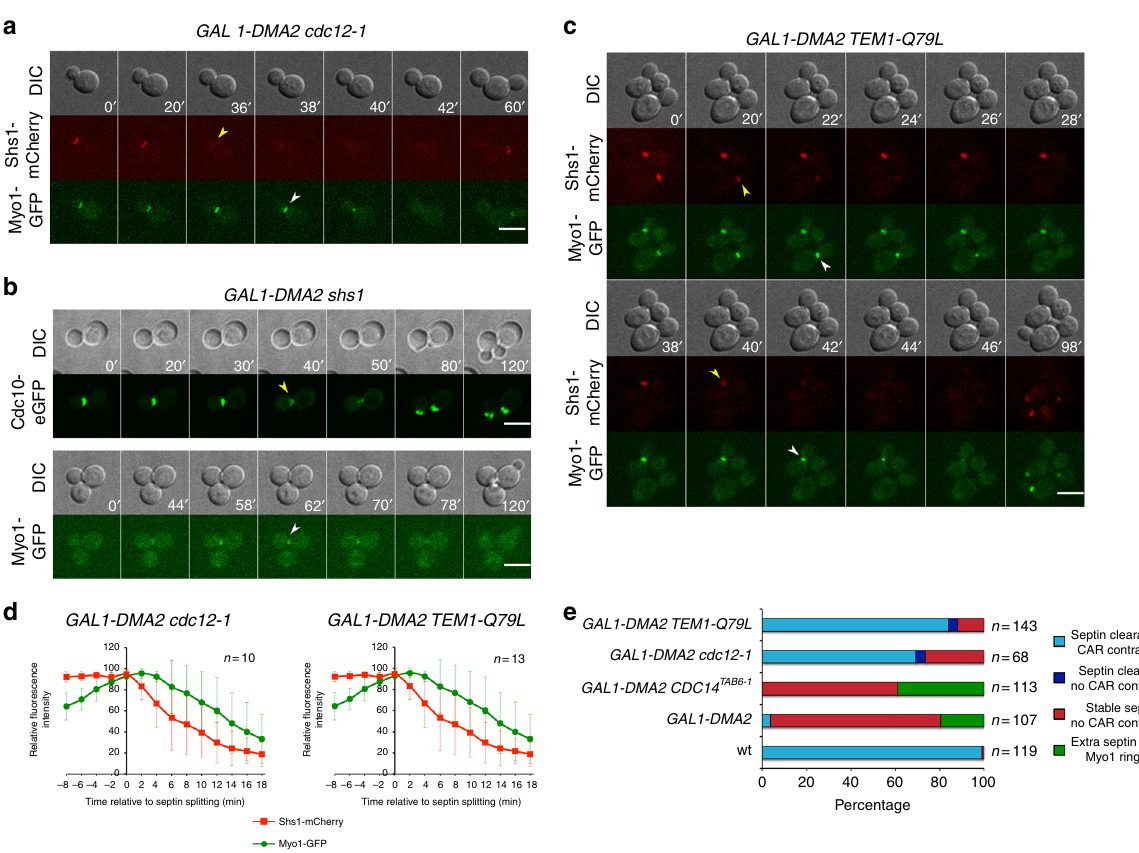
Fig. 4 Septin destabilization triggers CAR contraction in GAL1-DMA2 cells. a , c GAL1-DMA2 BUD4 cells with the indicated genotypes and expressing Shs1- mCherry and Myo1-GFP were grown in SD-raf fi nose and induced for 90 min with galactose before being mounted with SD raf fi nose/galactose for imaging at 30 °C (every 2 min for 2 h). Arrowheads indicate disassembly of septin rings (yellow) or the onset of CAR constriction (white). DIC differential interference contrast. b GAL1-DMA2 BUD4 shs1 Δ cells expressing either Cdc10-eGFP (upper panel) or Myo1-GFP (bottom panel) were treated as in a . Scale bar: 5 μ m. d Quanti fi cation of fl uorescence intensities associated to Shs1-mCherry and Myo1-GFP around the time of septin ring splitting (time 0) in GAL1- DMA cdc12-1 ( n = 10) and GAL1-DMA2 TEM1-Q79L cells ( n = 13): red squares: Shs1-mCherry; green circles: Myo1-GFP. Error bars: s.d. e Cells with the indicated genotypes and expressing Shs1-mCherry and Myo1-GFP were induced with galactose for ~90 min and imaged every 2 min for 2 h at 30 °C in SD- raf fi nose/galactose. Cells were classi fi ed according to their behavior for what concerns septin ring splitting and CAR